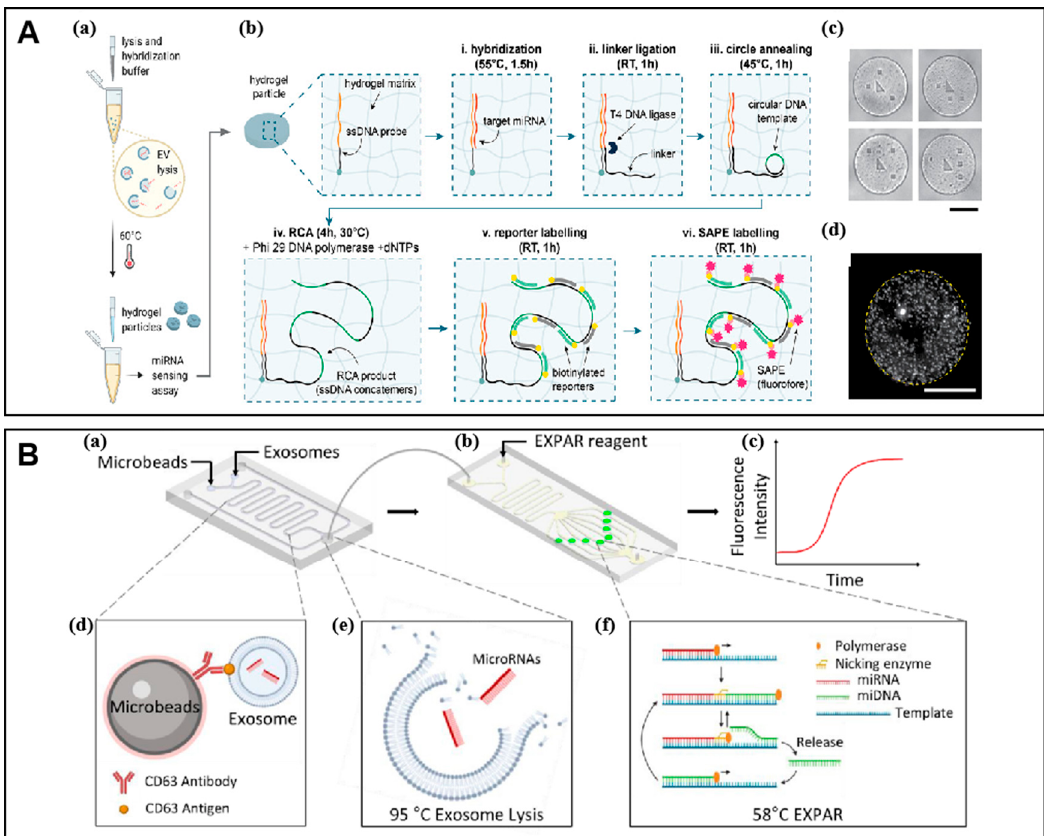
Figure 3. Examples of enzyme-assisted signal amplification for exo-miRNA detection. ( A ) Schematic of the miRNA capture and detection by encoded hydrogel microparticles. (a) The one-pot procedures of EV lysis and miRNA capture. (b) RCA in hydrogel microparticles. (c) Microscopic images of multiple sensing with four graphically encoded hydrogel particles. (d) The single hydrogel microparticle imaged by confocal fluorescence microscopy. Adapted with permission from [62]. Copyright 2022 Wiley-VCH GmbH. ( B ) Schematic of the on-chip exo-miRNA analysis. (a)-(c) The exosomes were captured and lysis for detection of miRNA by isothermal EXPAR assay. (d) The capture of CD-63 expressed exosomes by anti-CD63-coated magnetic beads. (e) Release of exosomal miRNAs by 95 ℃ lysis. (f) The isothermal EXPAR assay. Adapted with permission from [63]. Copyright 2021 Elsevier.